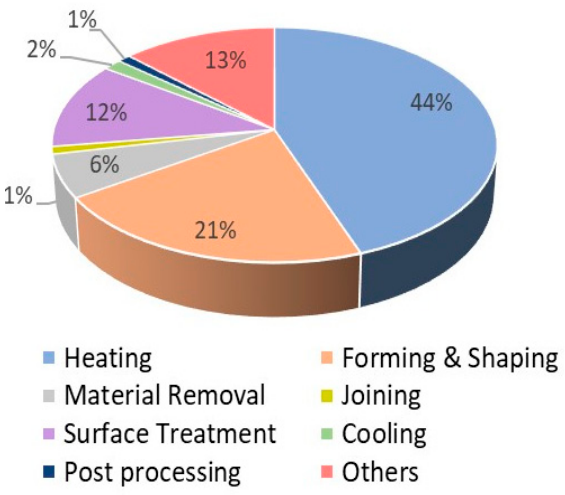
Figure 10. The share of EEU for production unit processes in the Swedish engineering industry.